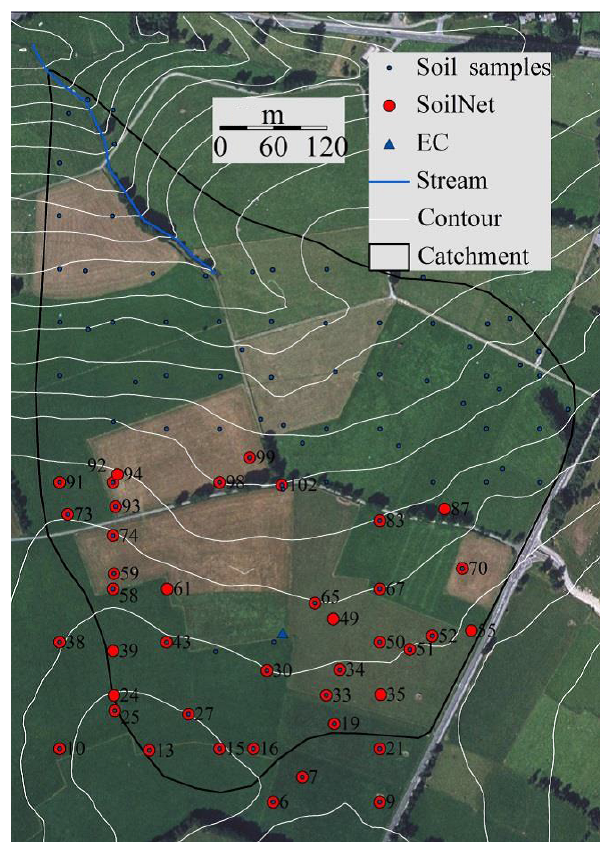
Figure 1. Aerial photograph of the 270000m 2 Rollesbroich exper- imental test site near the city of Rollesbroich in the Eifel moun- tain range, western Germany (photo is taken from Qu et al., 2014). The solid black line signifies the outer perimeter of our site and is determined in part by topographic gradients except for the Rolles- broich Straße which acts as border in the East-Southeast part of our domain. The small blue dots characterize locations within the watershed where soil samples were taken. The larger red dots are locations of the sensor network where soil moisture and tempera- ture were recorded at depths of 5, 20, and 50cm. The blue triangle symbolizes the eddy covariance